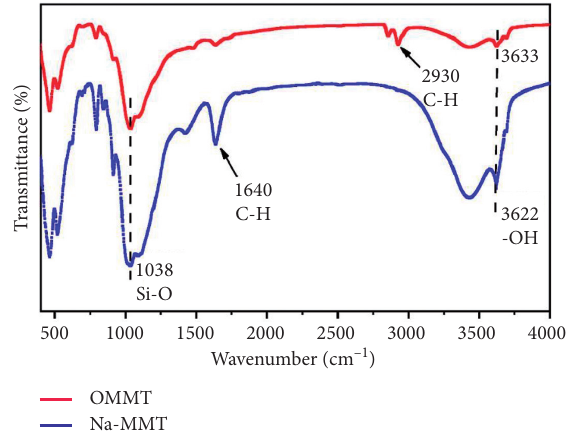
Figure 3: FTIR spectra of Na-MMT and OMMT.